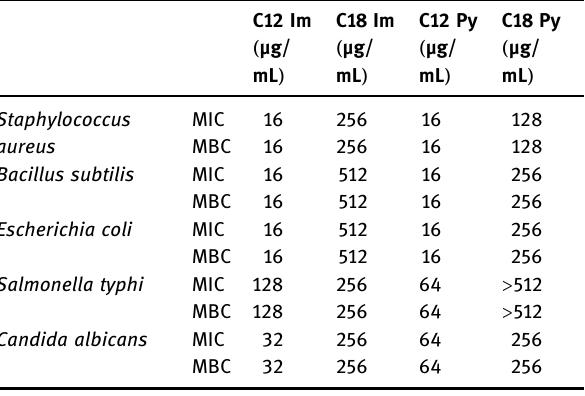
Table 2: The MIC and MBC of the tested nanoparticles against each